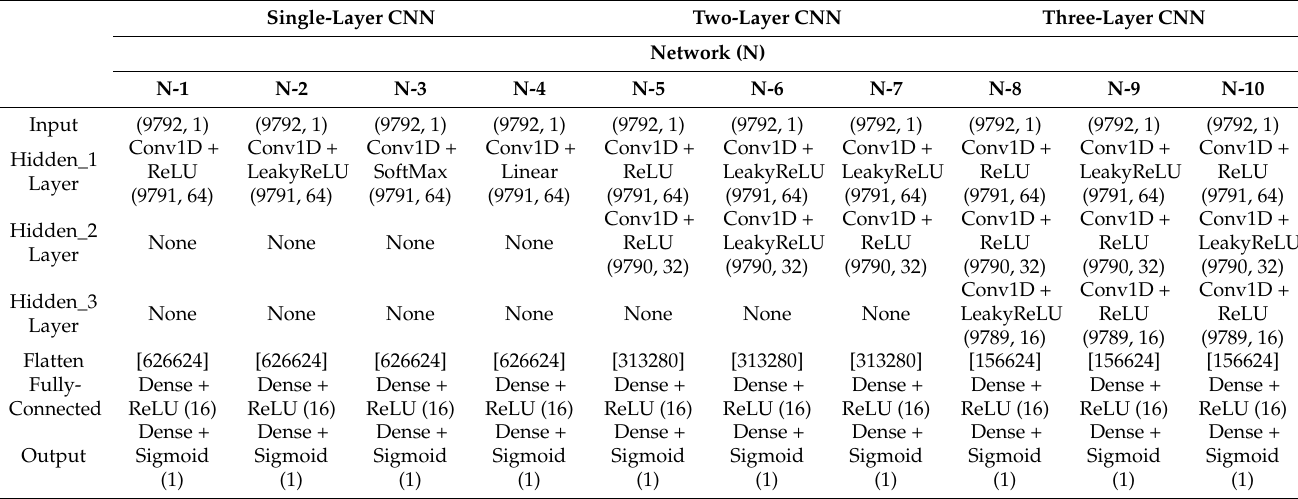
Table 2. Detailed CNN architecture for multi (12)-lead ECG with 1-convolutional, 2-convolutional, and 3-convolutional layers,